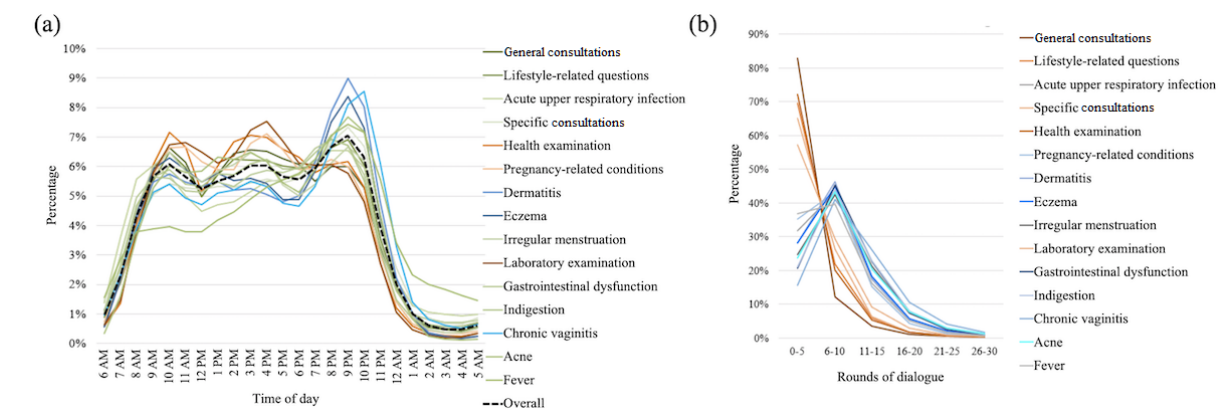
Figure 7. Characteristics of users' behaviors regarding the top 15 diseases: (a) distribution of times of day of consultations; (b) distribution of rounds of dialogue between users and physicians.